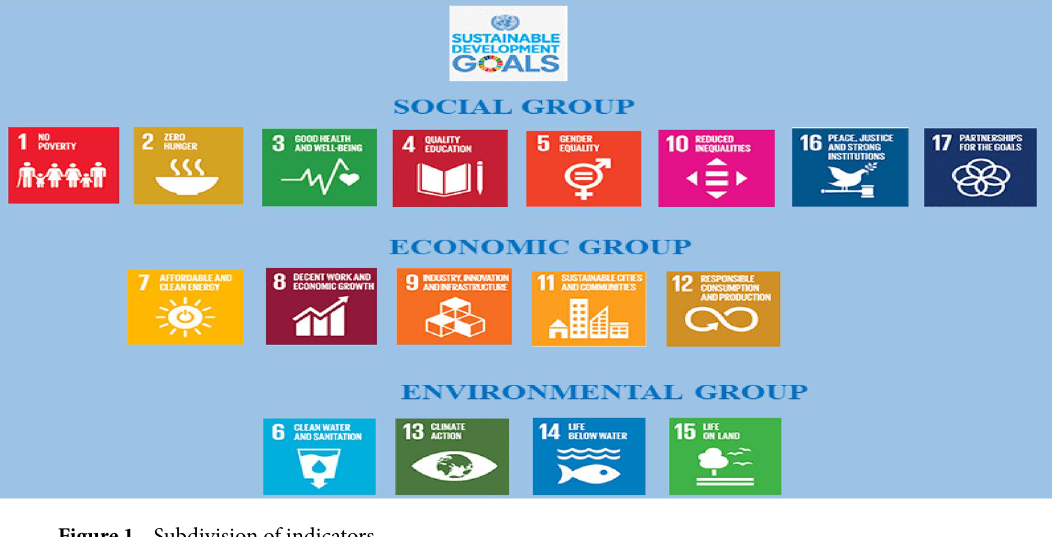
Figure 1. Subdivision of